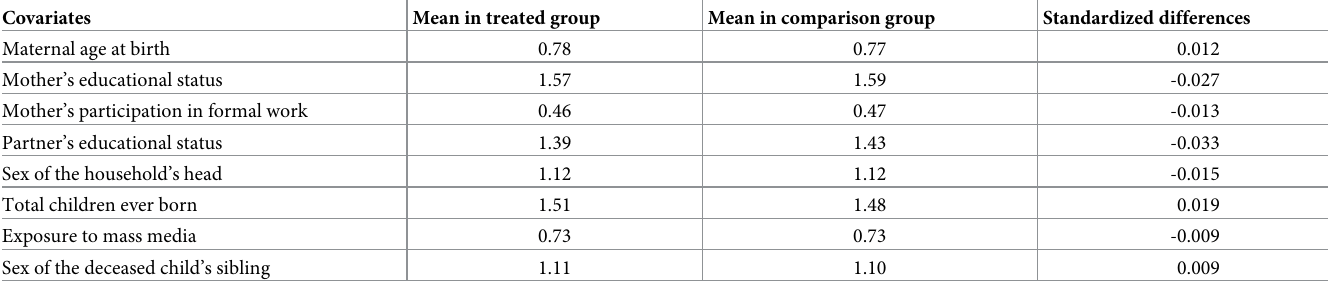
Table 3. Covariates PS balance before and after